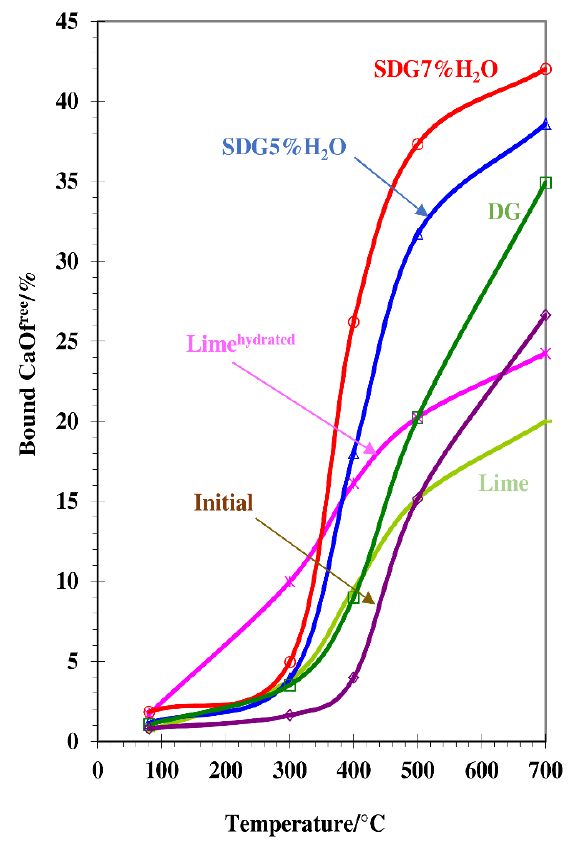
Figure 8. SO 2 binding efficiency of sorbents calculated on the content of free CaO bound (%) after 45 min contact between solid and gaseous phases at different temperatures.